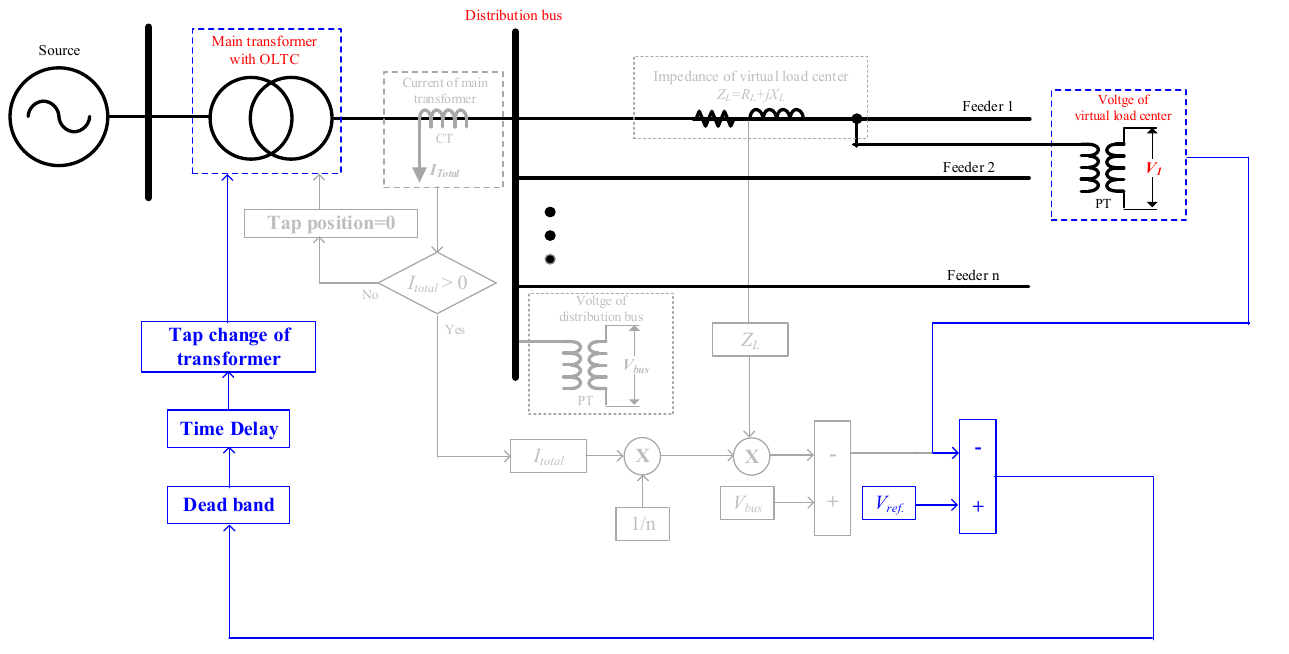
Figure 2. Mechanism of the DVM method and difference from the LDC method.